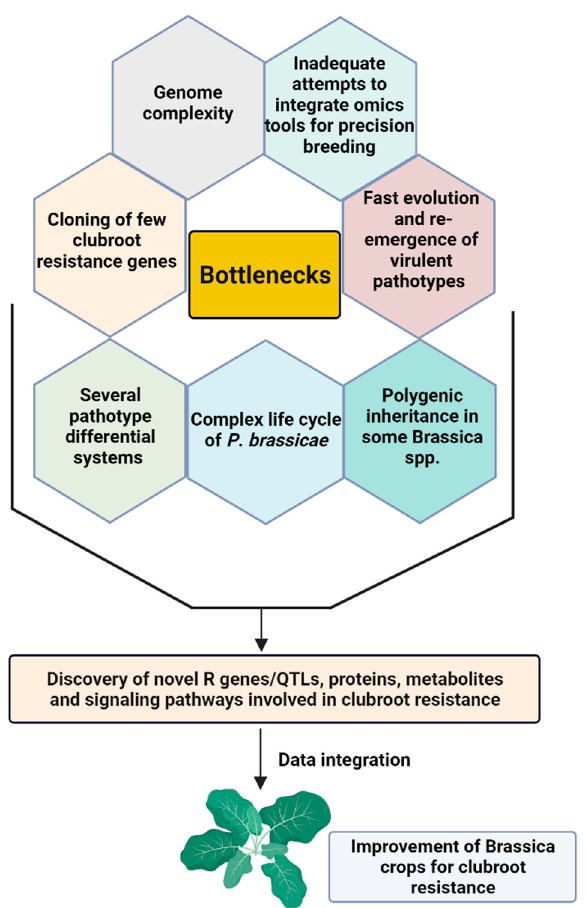
Figure 4. Existing bottlenecks in the utilization of multi-omics approaches to develop clubroot- resistant Brassica crops.